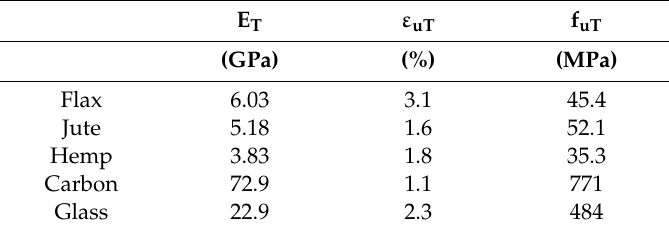
Table 2. Measured mean uni-axial tension coupon material properties of the fiber composite laminates (E T is the elastic modulus in tension, ε uT is the failure strain in tension, and f uT is the ultimate tension stress).